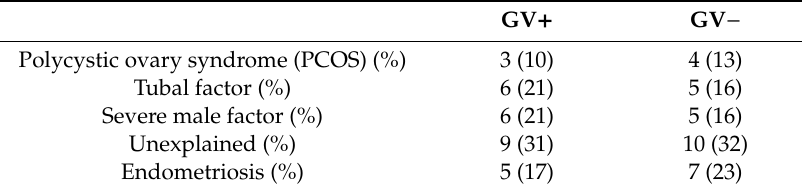
Table 2. Infertility factors.